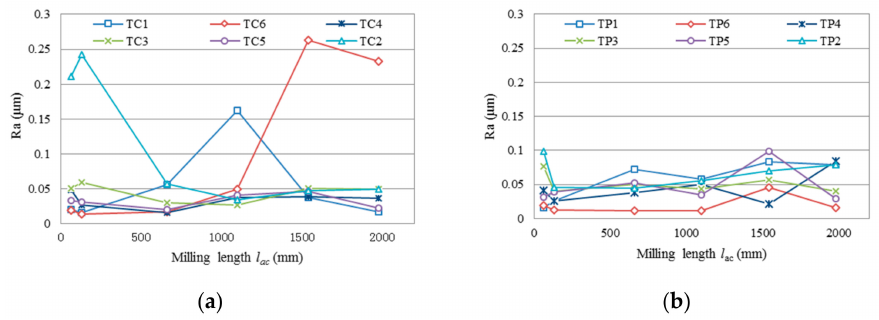
Figure 7. Surface roughness Ra verses milling length, ( a ) in test group TC; ( b ) in test group